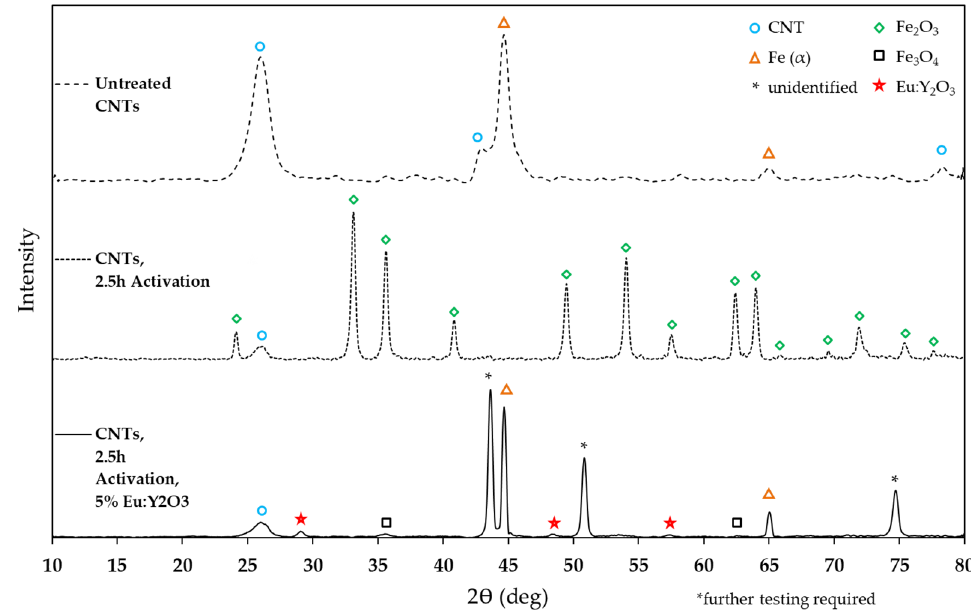
Figure 6. XRD analysis of untreated, activated, and Eu:Y 2 O 3 -CNT pulp with corresponding phases identified.